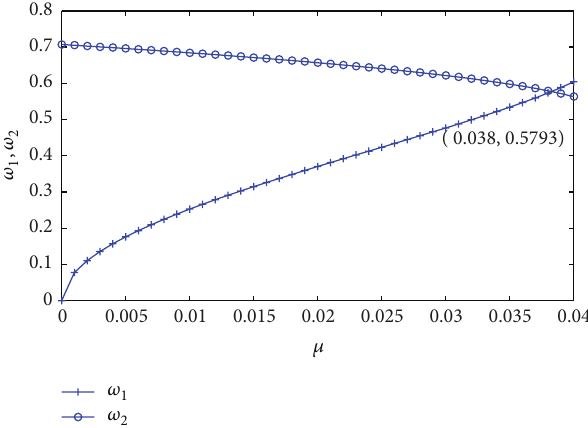
Figure 1: Correlation between 𝜇 and 𝜔 1 and 𝜔 2 with 𝛽 1 = 0.01 , 𝛽 2 = = 0.01 , and 𝐴 = 0.02 0.02 , 𝐴 1 2